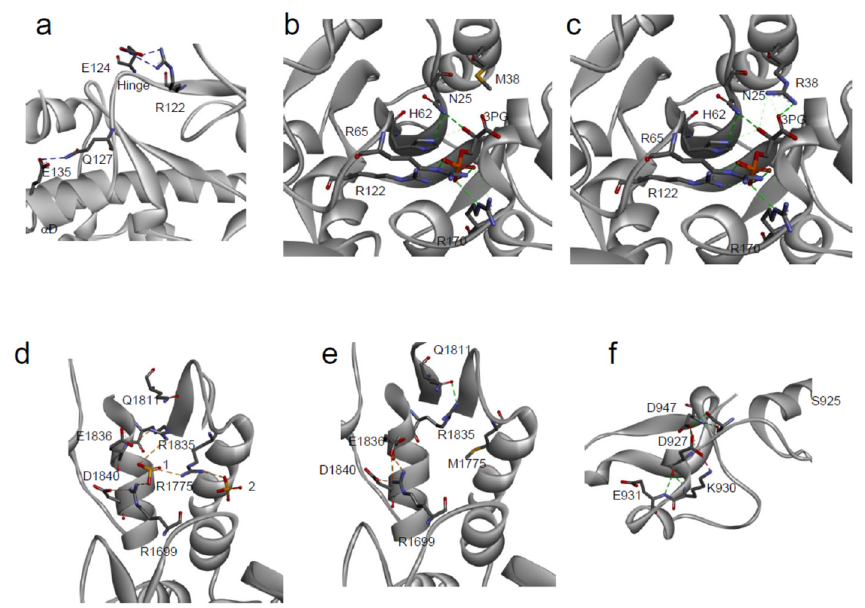
Figure 3. Local environment of SAVs. ( a ) PIM-1: Detailed view of the local structural environment around the mutated residue E135 [86]; ( b , c ) PGK1: detail of the 3 phosphoglycerate (3-PG) binding site in the variant p.R38M ( b ) in comparison with the wild-type ( c ) [87]; ( d , e ) BRCA1: Structural rearrangements of p.M1775R variant ( d ) in comparison with the wild-type, 1 and 2 are two solvent ions ( e ) [88]; ( f ) PTP ρ : local environment of the mutated residue D927 [77].